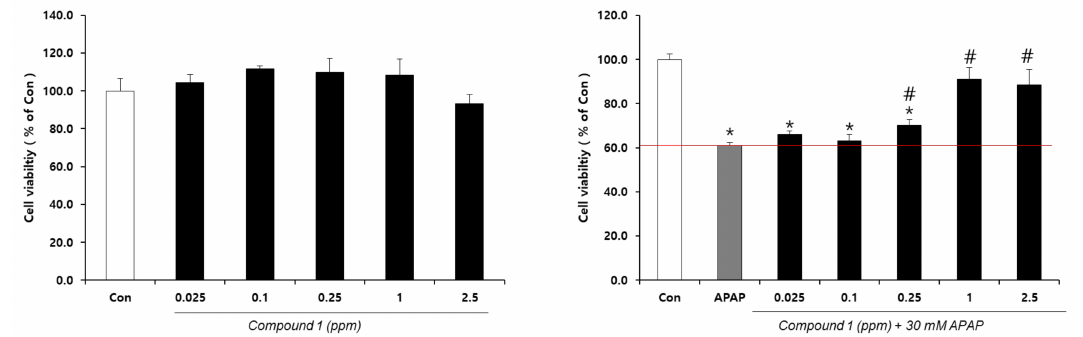
Figure 6. E ff ects of 4-(2-formyl-5-(hydroxymethyl)-1 H -pyrrol-1-yl)butanoic acid ( 1 ) on the cell viability of HepG2 without (left) or with (right) 30 mM acetaminophen (APAP). n = 4 or more; # and * indicate significant di ff erences from the APAP-only group and control, respectively ( t -test, p <